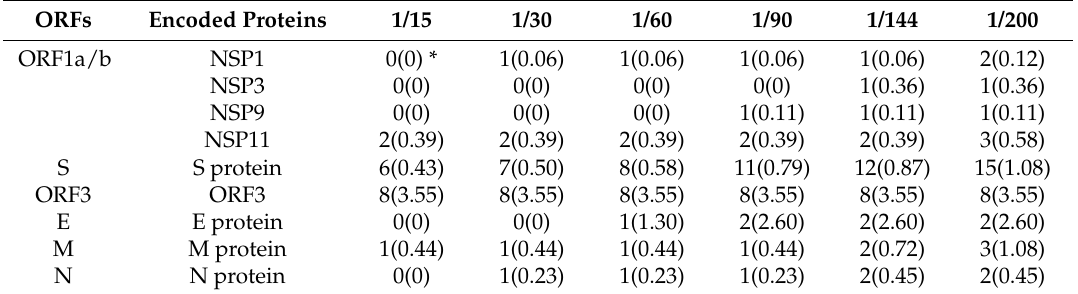
Table 2. Amino acid changes numbers and change rates between parental virulent YN1 and different Vero cell-adapted